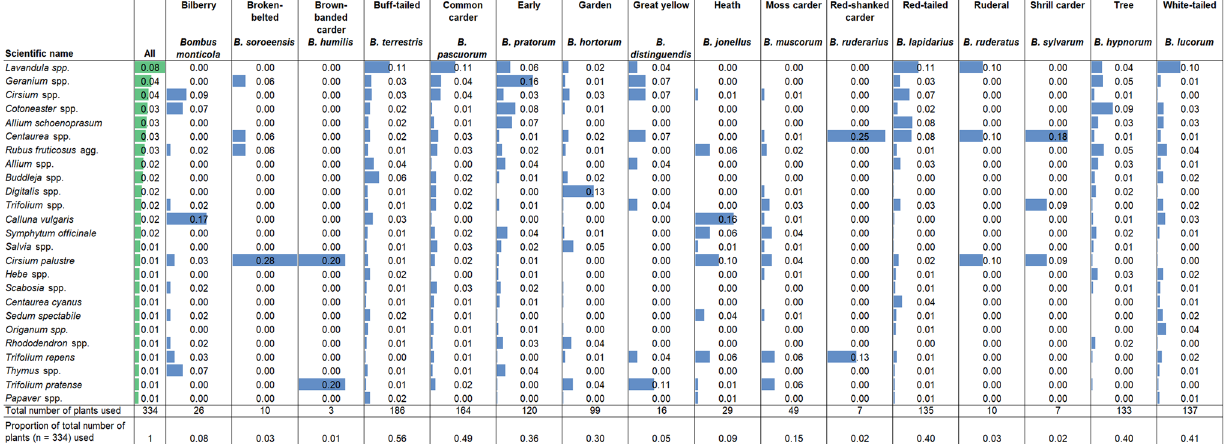
Table 1. Rank order of the top 25 plants used by bumblebees based on data from the citizen science programme BeeWatch. For each plant, its relative abundance (i.e. proportion) on the BeeWatch database was calculated, for all bumblebee species combined (‘All’) and for each of the 16 true bumblebee species. Coloured bars are included to aid interpretation, whereby the top plant of a certain bumblebee species attracted the widest colour bar, and the colour bars of the other plants are proportional to that top plant. Where the bar is not the full width of the column, a species not in the overall top 25 list was the most widely used for that bumblebee species. The total number of plants observed (for all bumblebees combined and individual species respectively) is provided in the second row from the bottom. The bottom row details the proportion of plants (from a total of 334) used each individual bumblebee species. Data compiled from information recorded by BeeWatch participants between August 2011 and June 2017 (6429 bumblebee–plant